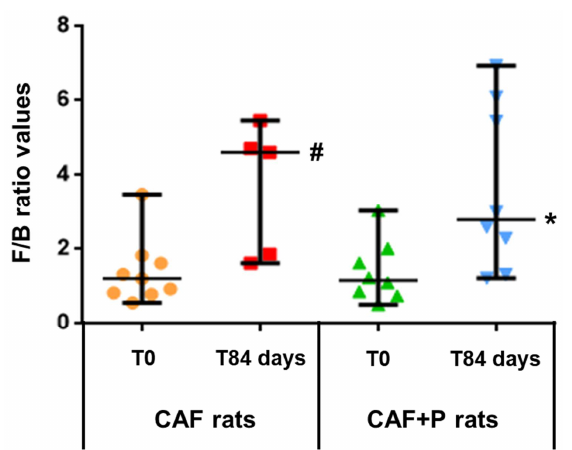
Figure 7. Firmicutes/Bacteroidetes (F/B) ratio calculated at T0 and after 84 days of CAF diet without and with probiotic supplementation. # p < 0.05 vs. CAF rats T0; * p < 0.05 vs. CAF rats T84. CAF: cafeteria; P: probiotic